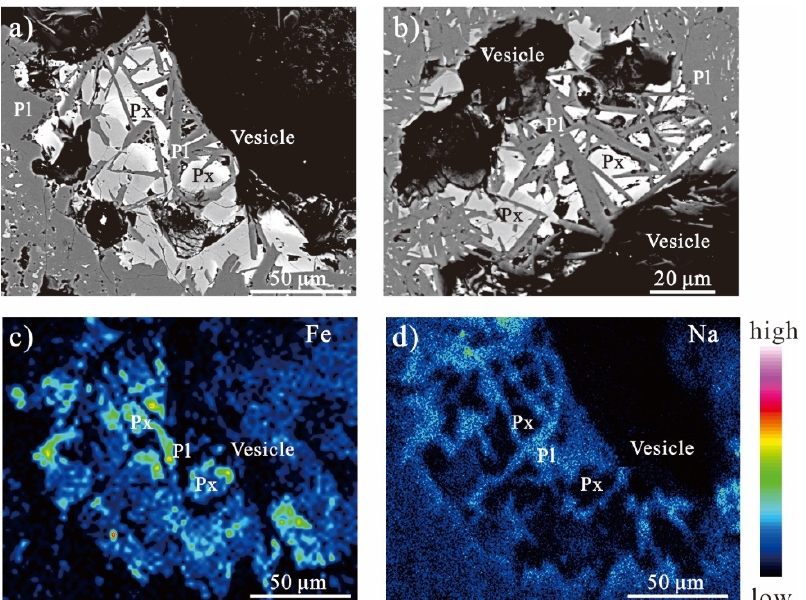
Figure 5. Backscatter electron images of two basaltic clasts and scanning results for Fe and Na. ( a ) Backscatter image of BC 01. ( b ) Backscatter image of BC 02. ( c ) Distribution map of Fe content in BC 01, showing that pyroxene (Py) has compositional zoning. ( d ) Distribution map of Na content in BC 01, showing that the clast is more enriched in Na than the matrix.